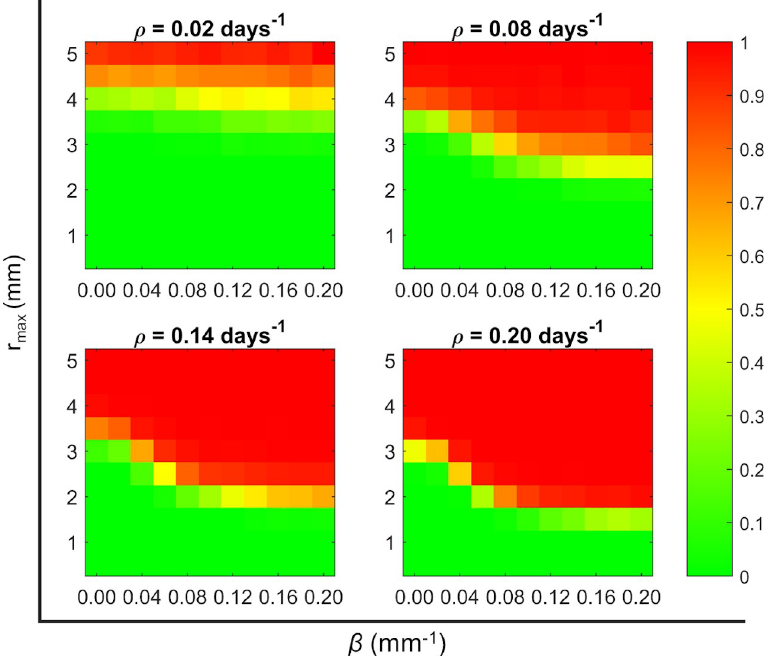
Fig 10. Active Disease Index for different sets of parameters. Exploration of parameters space ( r max , β and ρ ) to see the fraction of in silico experiments that present an active TB disease. The colour is proportional to this frequency; green colour means most of the cases remained latent, red colour means that most of the cases derived into an active disease, and intermediate colours mean that both dynamics are possible.